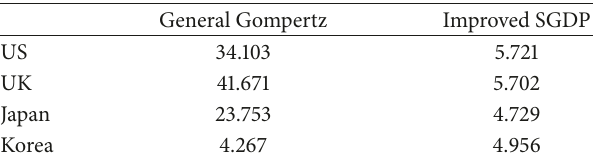
Table 3: Prediction standard errors of improved SGDP and general Gompertz in sample countries.